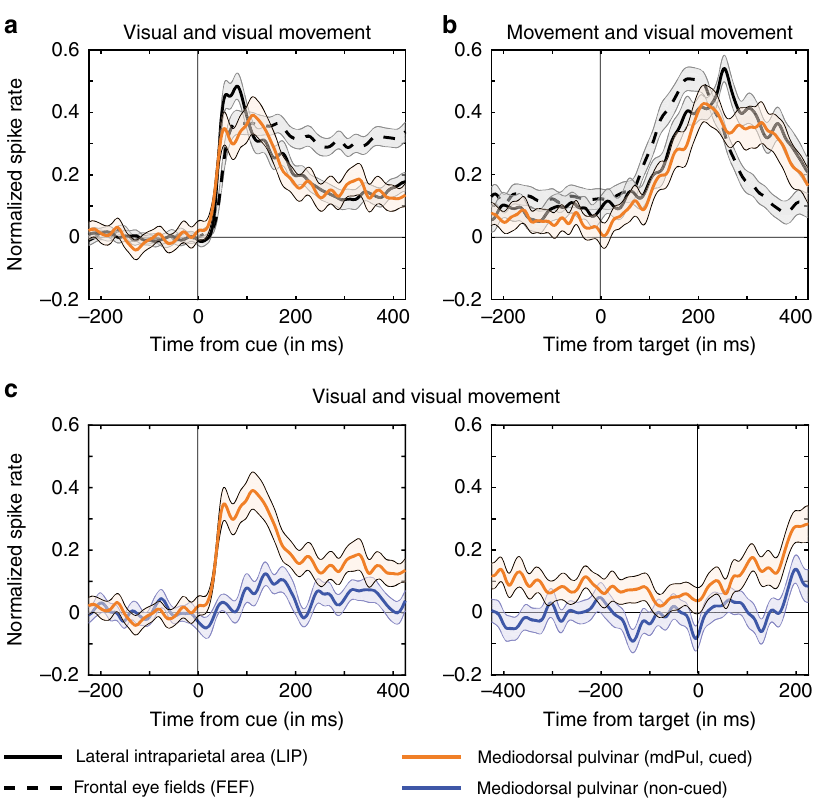
Fig. 3 mdPul contributes to the maintenance of spatial attention at a cued location. a Normalized, cue-locked spike rates, averaged across the population of neurons with signi fi cantly increased visual-sensory responses (i.e., visual and visual-movement neurons) when receptive fi elds overlapped the cued location. b Normalized, target-locked spike rates, averaged across the population of neurons with signi fi cantly increased movement responses (i.e., movement and visual-movement neurons) when receptive fi elds overlapped the cued location. c Normalized spike rates in mdPul, time-locked to either the cue (left) or the target (right), both when receptive fi elds overlapped the cued location (orange) and when receptive fi elds overlapped the non-cued location (blue). These plots are averaged across all mdPul neurons with a signi fi cantly increased visual-sensory response (i.e., visual and visual-movement neurons). Shaded regions around the lines represent